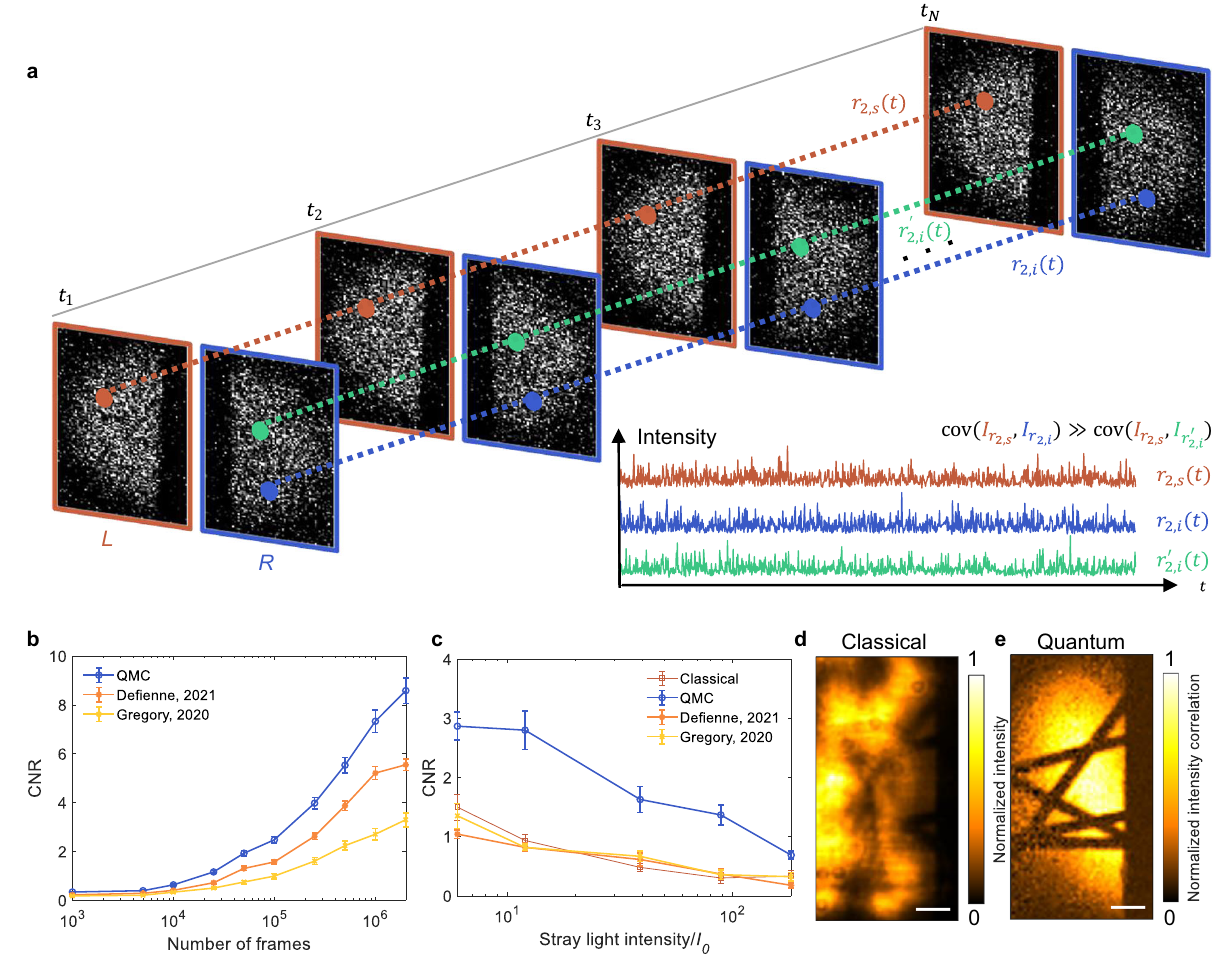
Fig.2|CoincidencemeasurementofQMC.a Thecoincidencemeasurementrelies onthefactthatthecovariancebetweenentangledphotonsinasequenceofframes is much larger than the covariance between two random photons. L and R refer to the left and right regions of the EMCCD, which are used to detect the signal and idler photons, respectively. r 2, s and r 2, i aresymmetric positions onthedetector for the signal and idler photons. r ′ 2, i is a random position in the right region and different from r 2, i . Inset, intensities ( I ) at the three positions in different frames. b CNRs of QMC and the wide- fi eld quantum imaging methods in refs. 23,24 using